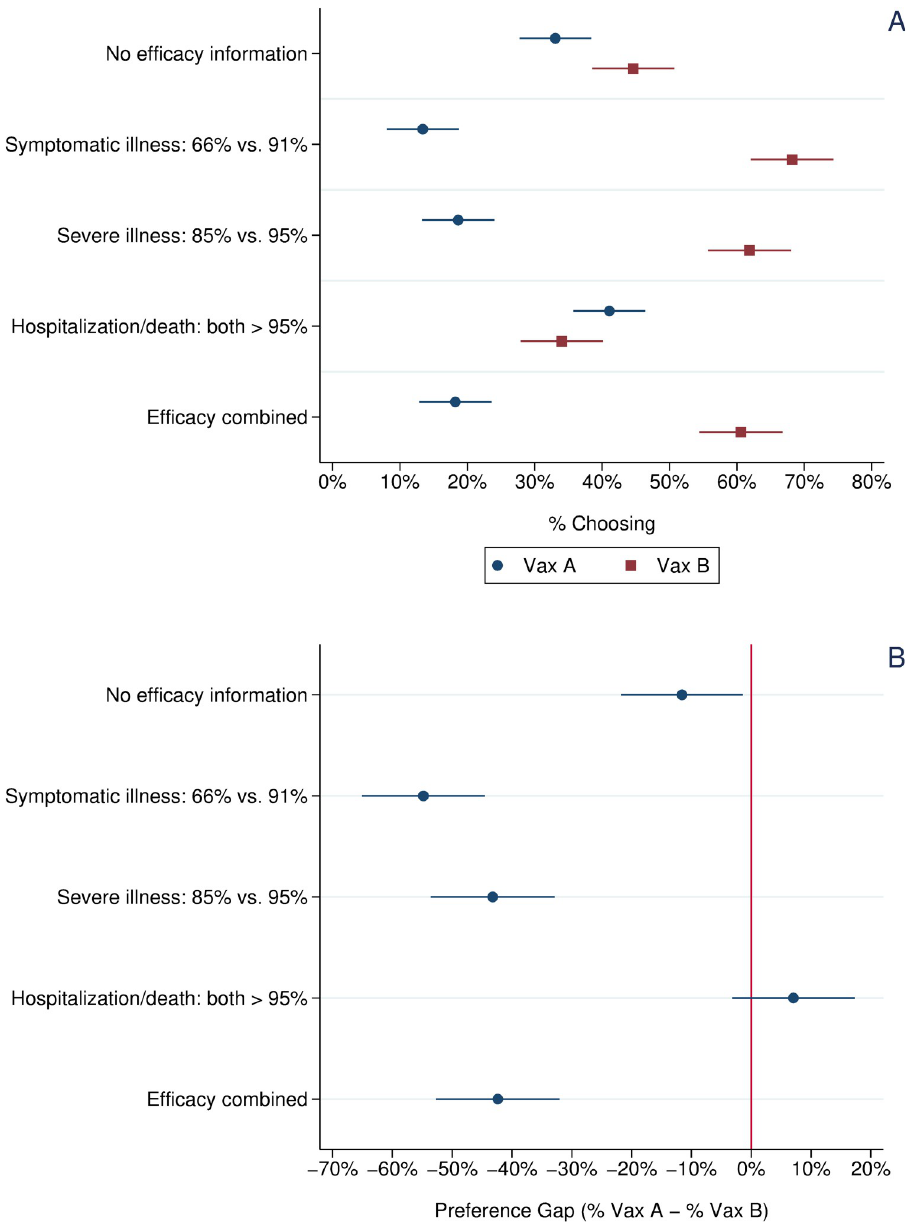
Fig 1. Vaccine choice and preference gap across experimental treatments, all respondents. Note : Panel A: Circles indicate the percentage choosing Vaccine A, a one-shot, viral vector vaccine with efficacy data mirroring that reported in the Janssen vaccine trials. Squares indicate the percentage choosing Vaccine B, a two-shot, mRNA vaccine with efficacy data mirroring that reported in the Pfizer vaccine trials. Panel B: Circles indicate the preference gap between Vaccine A and Vaccine B. Horizontal bars present 95% confidence intervals about each mean